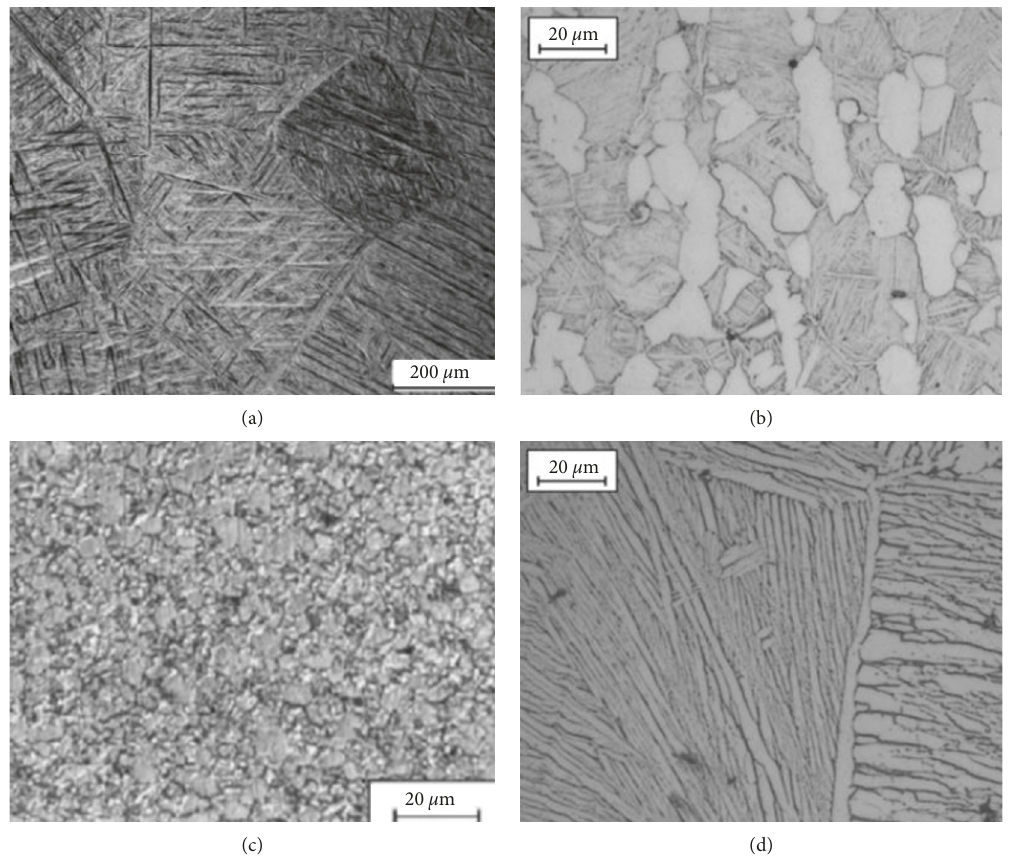
Figure 2: Ti6Al4V microstructures: (a) martensitic α ´ , (b) bimodal, (c) equiaxed, and (d) lamellar [10, 11].